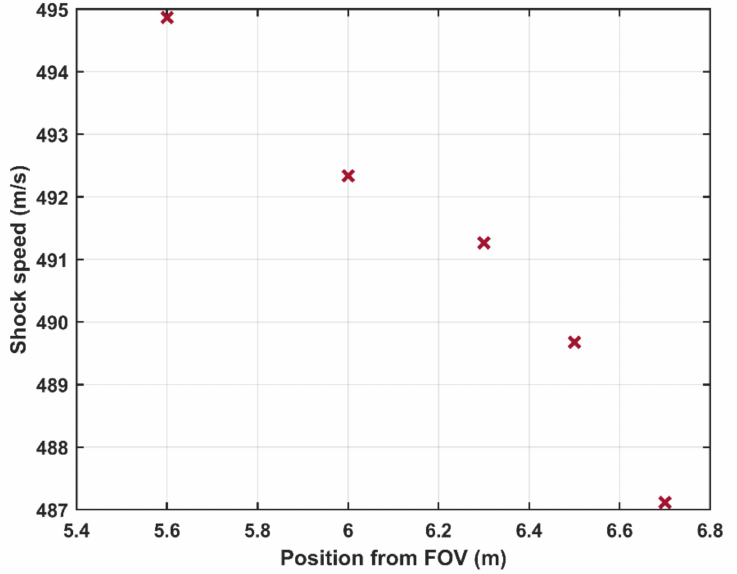
Figure 4. The shock speed at different positions from the FOV. Driven section length (L 1 ) is 7